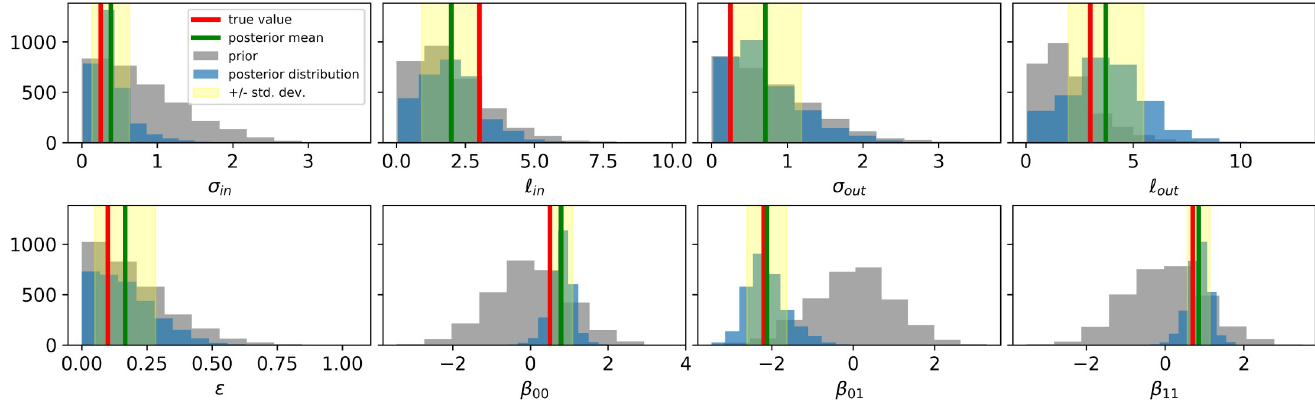
Fig 5. Inference on synthetic dataset. The T-SBM accurately recovers the true generative parameters even when the target notably differs from the prior distribution.